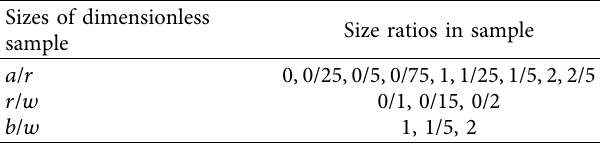
Table 15: Explained ratios for analysis and modeling. Sizes of dimensionless